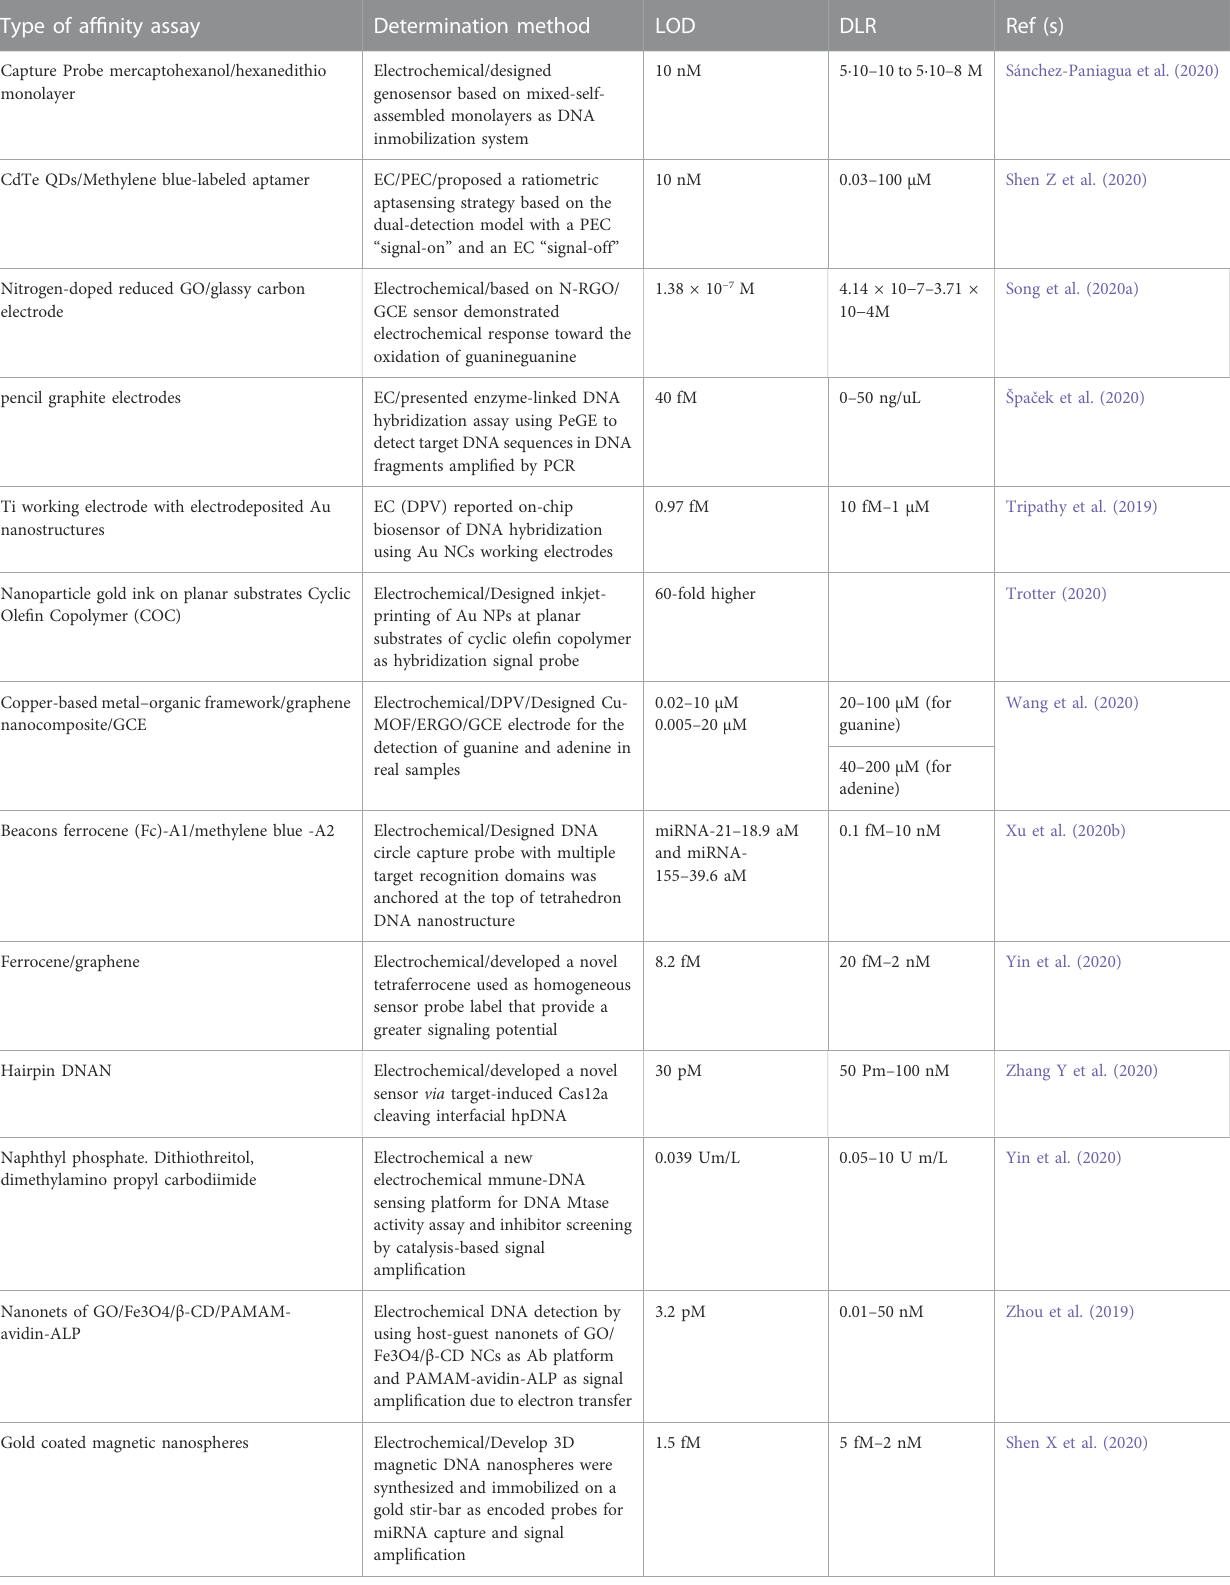
TABLE 5 ( Continued ) ECL-based DNA detection